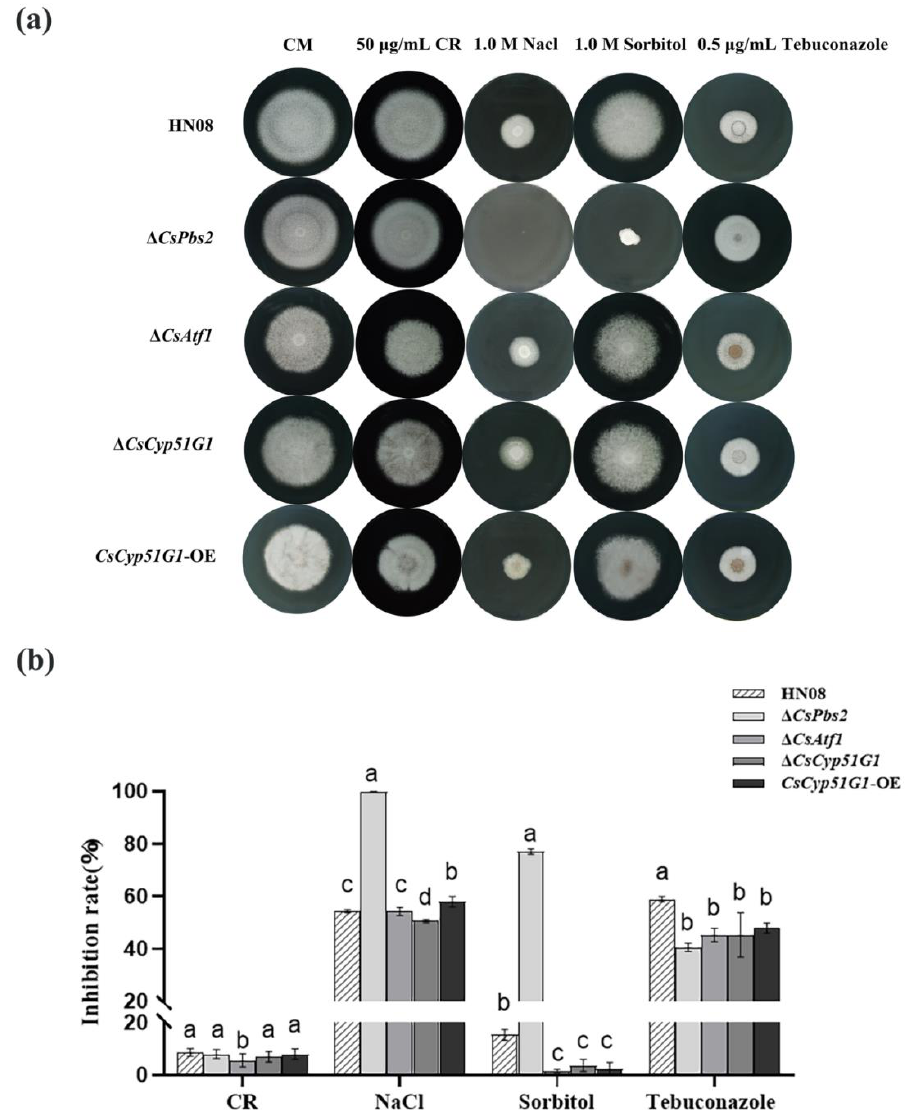
Figure 6. Comparison of responses to various stresses among HN08, ∆ CsPbs2 , ∆ CsAtf1 , CsCyp51G1-OE, and ∆ CsCyp51G1 . ( a ) Mycelial growth of HN08, ∆ CsPbs2 , ∆ CsAtf1 , CsCyp51G1-OE, and ∆ CsCyp51G1 on CM containing 1 M NaCl, 1 M sorbitol, 50 µ g/mL Congo red, and 0.5 µ g/mL tebuconazole for 5 d. Approximately 1 × 10 6 conidia of each strain were inoculated onto the center of the CM plates and grown for 5 d. ( b ) Growth inhibition rates of the tested strains under different stresses. The growth inhibition rate is relative to the growth rate of each untreated control [(diameter of untreated strain − diameter of treated strain)/(diameter of untreated strain × 100%)]. Three repeats were performed. Error bars represent the standard deviations. Different letters (a, b, c, d) represent significant difference at p < 0.01 (One-wa y ANOVA and Duncan’s test ).